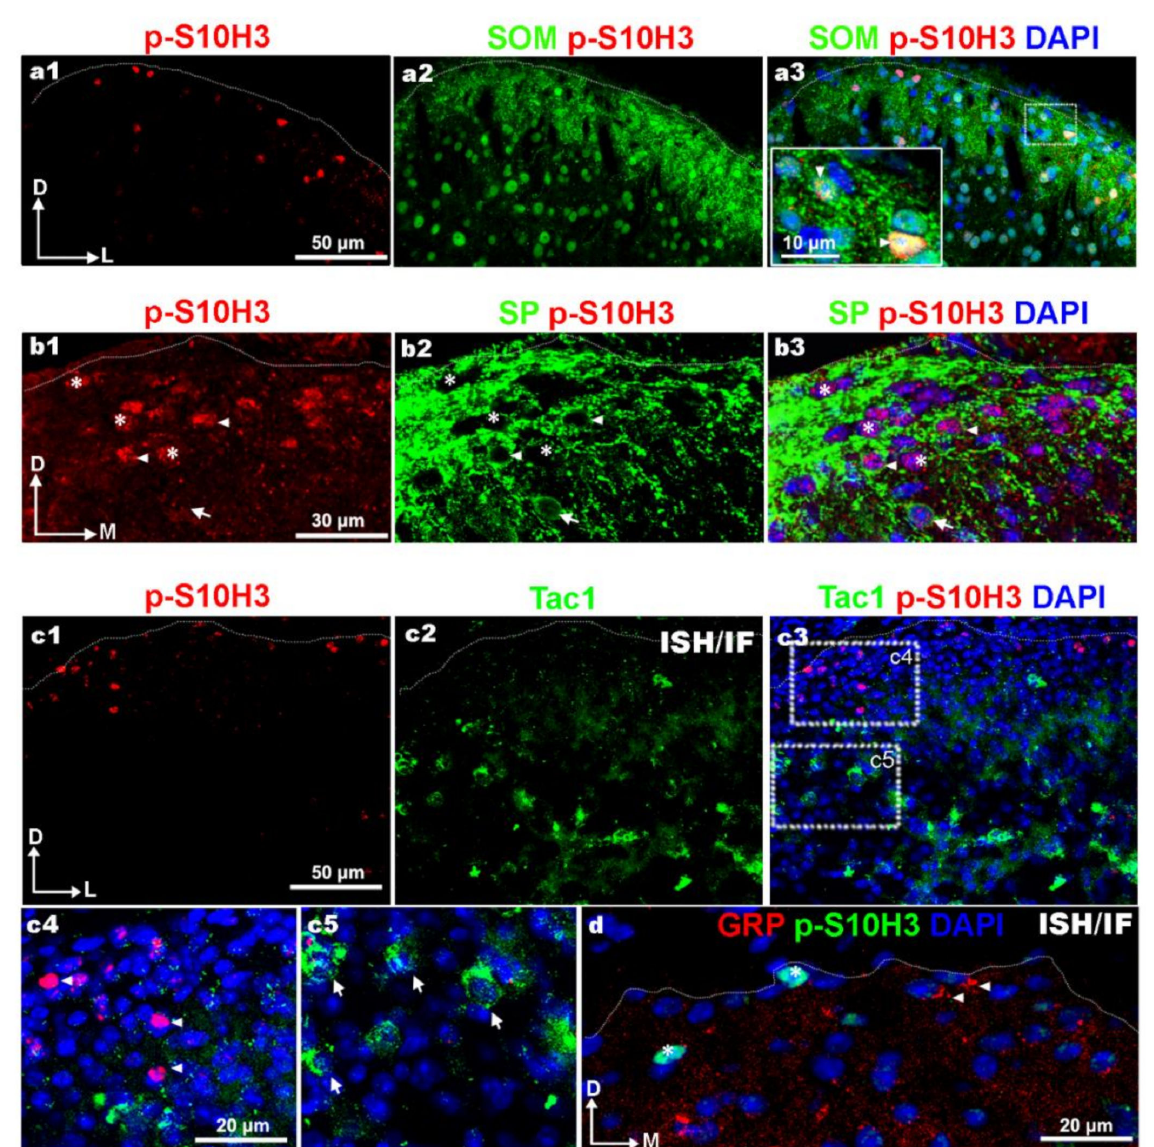
Figure 6. Burn injury-induced S10H3 phosphorylation in excitatory subpopulations of SDH neurons. ( a1 – a3 ) A representa- tive image showing immunostaining for p-S10H3 (red; a1 , a3 ) and somatostatin (SOM; green; a2 , a3 ) in a transverse section of wild-type mouse. ( a3 ) shows a merged image with 4 (cid:48) ,6-diamidino-2-phenylindole (DAPI) (blue). In the inset there are two p-S10H3-positive neurons that exhibit strong SOM labeling in their cytoplasm (arrowheads). ( b1 – b3 ) A representative image showing immunostaining for p-S10H3 (red; b1 , b3 ) and substance P (SP; green; b2 , b3 ) in a transverse section of wild-type mouse. ( b3 ) shows a merged image with DAPI (blue). There are some SP-containing neuronal soma with (arrowheads) or without p-S10H3 (arrow) in their nuclei. Asterisks show p-S10H3-IR neurons that probably do not produce SP. ( c1 – c5 ) A representative image showing immunostaining for p-S10H3 (red; c1 , c3 ) and in situ hybridization (ISH) signal for Tac1 mRNA (green; c2 , c3 ). ( c3 ) shows a merged image with DAPI (blue). Insets represent higher magnification views of regions of interest designated on image ( c3 ). Arrowheads label p-S10H3-IR neurons that probably do not produce substance P due to its low level of Tac1 mRNA ( c4 ). Arrows indicates Tac1 mRNA containing cell bodies that do not show p-S10H3-IR ( c5 ). ( d ) Immunostaining for p-S10H3 (green), cell nuclei specific DAPI (blue) and ISH signal for GRP mRNA (red). Interestingly, SDH neurons containing GRP mRNA (arrowheads) never express pS10H3-positive nuclei (asterisks) following burn injury. The dotted line indicates the border between gray and white matter ( a – d ). D, dorsal; L, lateral; M,